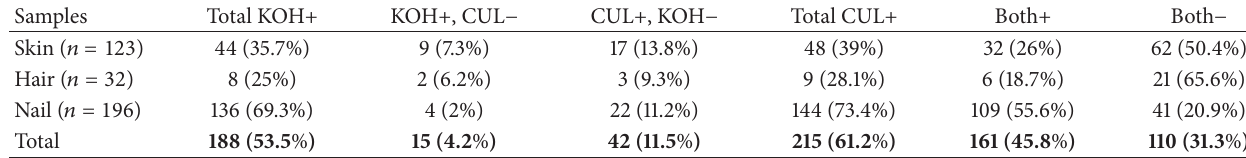
Table 2: Total samples received in the laboratory and correlation between sample type, KOH, and culture.